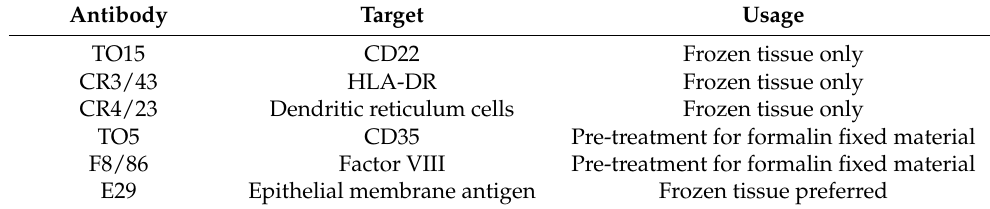
Table 1. Early examples of diagnostic